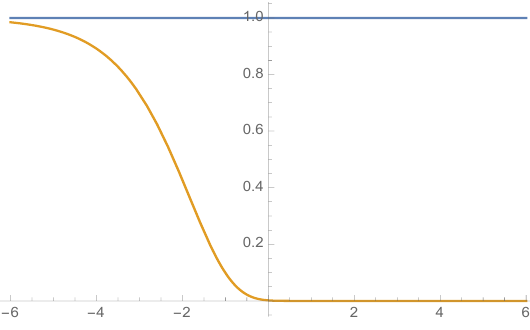
Figure 10 . Tadpole amplitude F ( x ) as a function of x + 2 [ (cid:0) 6 ; 6] with x (cid:0) =